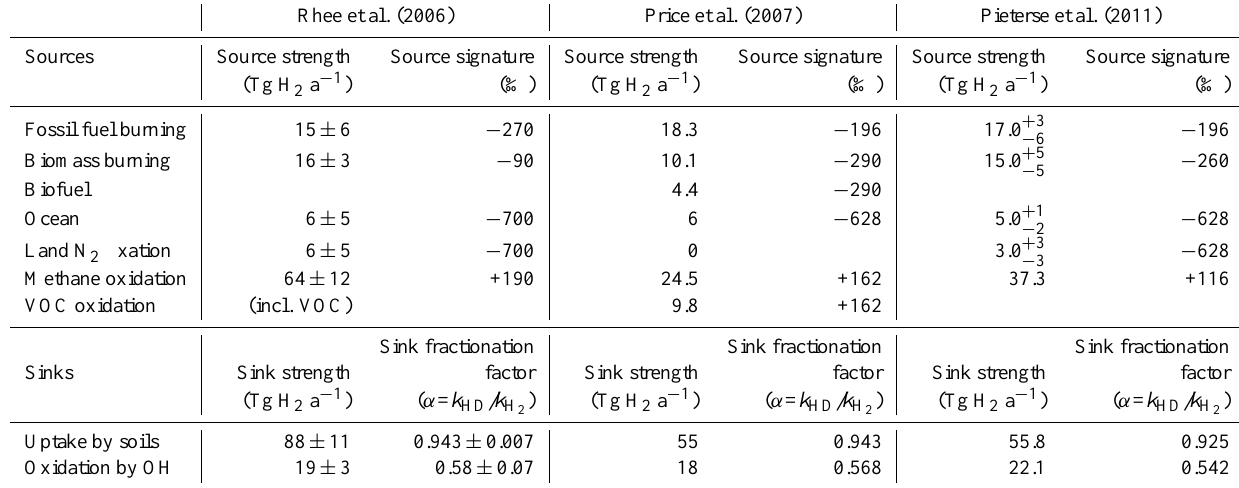
Table 1. The global budget of atmospheric H 2 , with source and sink strengths and isotopic signatures used by different authors. Rhee et al.